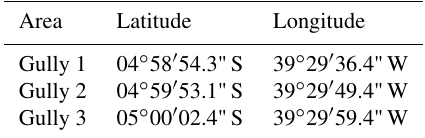
Table 1. Coordinates of the three gullies used in this study (Datum: